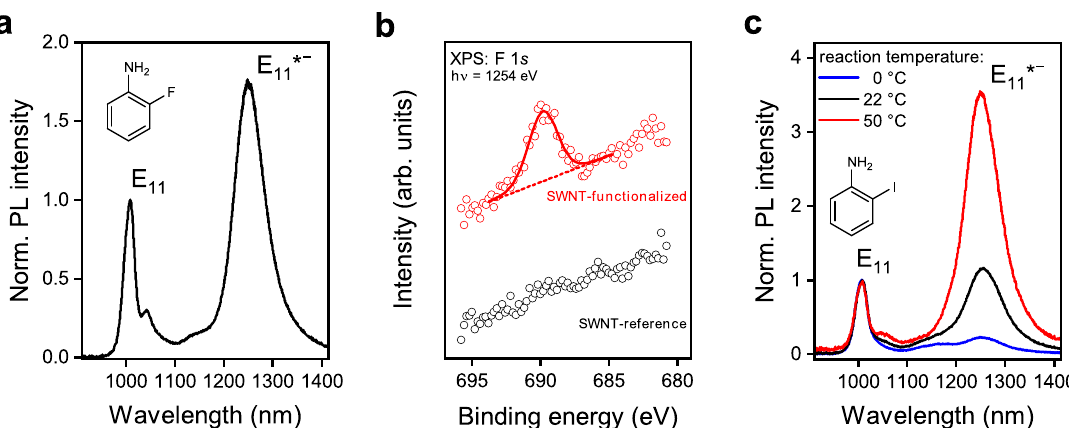
Fig. 5 Mechanistic investigation of functionalization. a PL spectrum of (6,5) SWNTs functionalized with 2- fl uoroaniline in the dark with a strong defect emission band at 1250 nm. b F 1 s XPS spectra of (6,5) SWNTs after reaction with 2- fl uoroaniline with (red circles including peak fi t, red line) and without (black circles; reference) addition of KO t Bu as base. The presence of the F 1 s signal indicates covalent functionalization with 2- fl uoroaniline, whereas the absence of this signal for the reference sample indicates lack of functionalization. c PL spectra of (6,5) SWNTs functionalized with 2-iodoaniline at different reaction temperatures in the dark. The concentrations of 2- fl uoroaniline and 2-iodoaniline were kept at 29.30 mmolL − 1 .